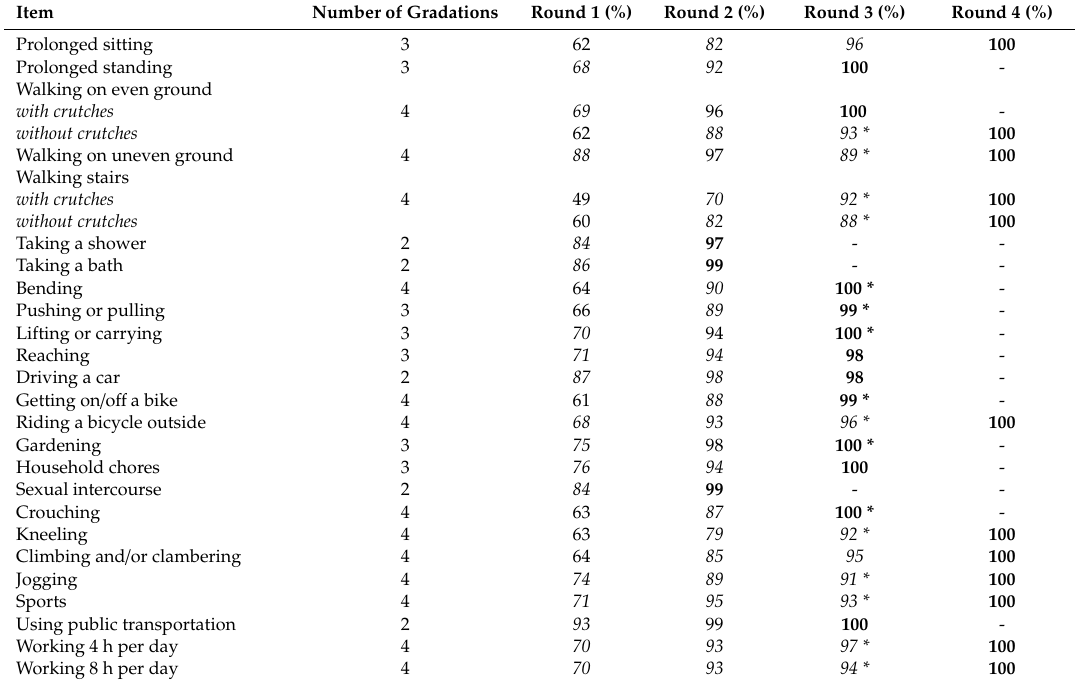
Table A1. Percentage of Consensus Reached Per Delphi Round for Total Knee Arthroplasty